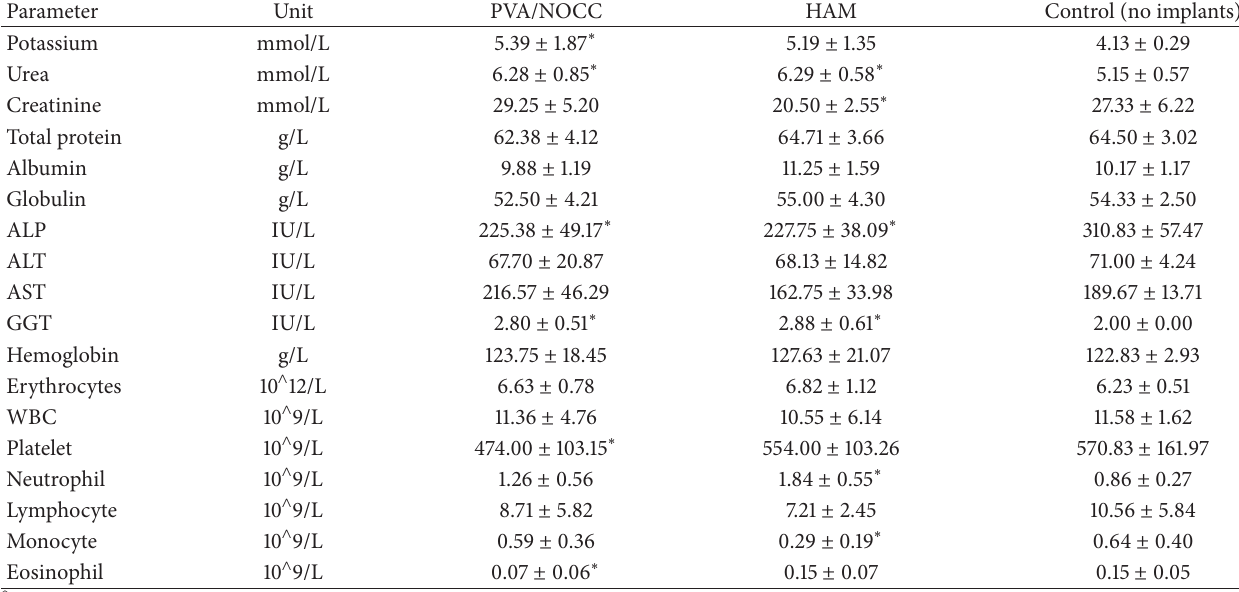
Table 2: Differences in the level of some biochemical indicators among groups of animals implanted with PVA/NOCC and HAM and control on the 10th day of implantation (mean ± SD).